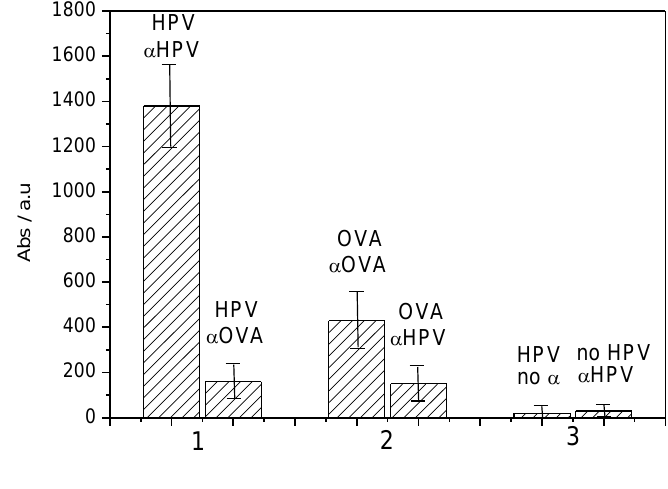
Figure 12. Absorbance obtained for spectrophotometric ELISA assays corresponding to: ( 1 ), HPV-16-L1 grafted, +  HPV (left bar) or +  OVA (right bar). ( 2 ) OVA grafted, +  OVA (left bar) or +  HPV (right bar). ( 3 ) HPV grafted + no antibody (pure PBS) (left bar), or nothing grafted +  HPV (right bar)